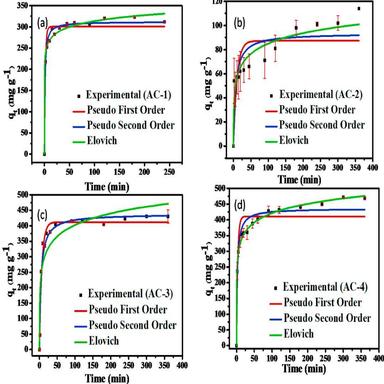
Kinetic curve for MB dye adsorptions by (a) AC-1, (b) AC-2, (c) AC-3 and (d) AC-4. Initialdye concentration used: 300 mg L− 1 for AC-2 and 500 mg L− 1 for the rest, dosage of 1 g L− 1 , pH 7.0 and temperature 298 ± 1 K.